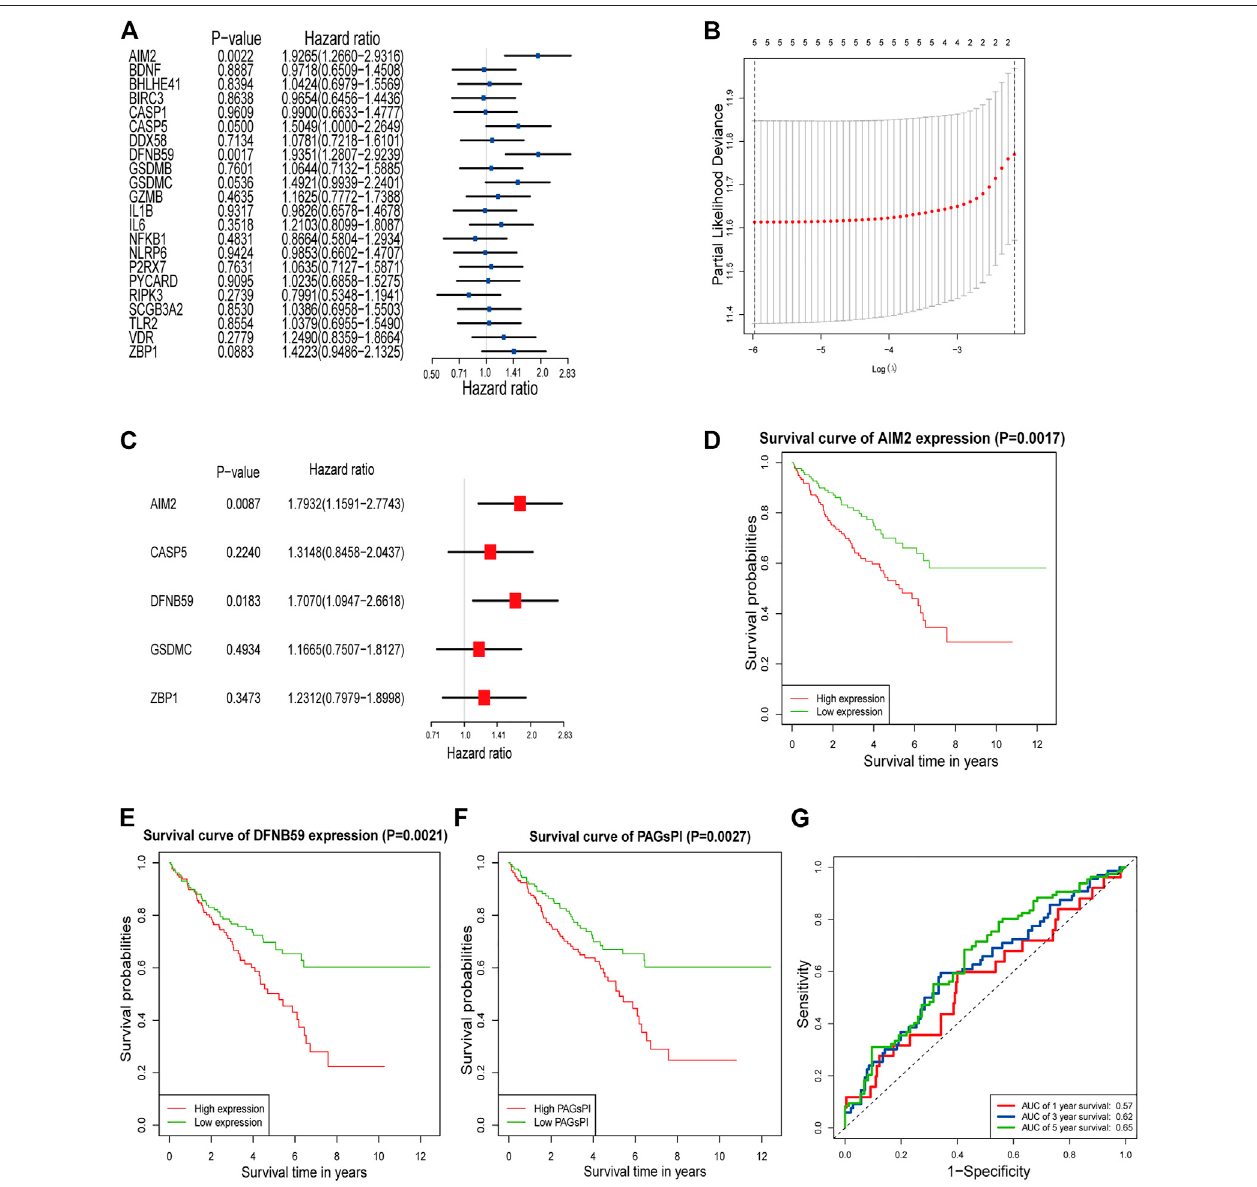
FIGURE 1 | Identi fi cation of PAGs linked to overall survival and construction of PAGsPI. (A) Univariate Cox regression analysis results of the 22 DEPAGs. (B) The results of LASSO regression analysis, identifying minimum criteria. (C) The results of multivariate Cox regression analysis, determining independent prognostic factors and calculating their coef fi cient. (D – F) KM survival analysis of AIM2, DFNB59 and PAGsPI. (G) ROC curve of PAGsPI for predicting 1-year, 3-year and 5-year survival.